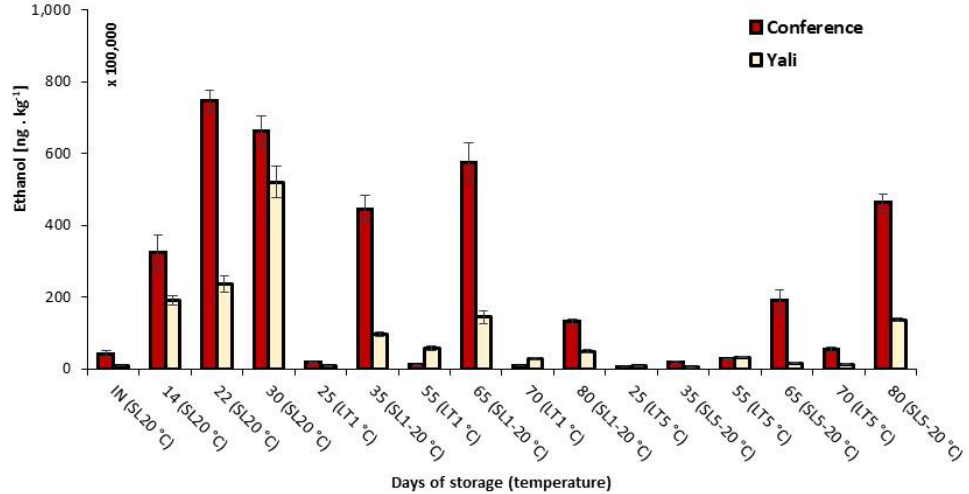
Figure 1. Concentration changes of ethanol in ‘Conference’ and ‘Yali’ pear cultivars depending on time and storage regimes. (SL20 °C — shelf-life at 20 °C; LT — low storage at 1 or 5 °C; SL1-20 °C, SL5-20 °C — shelf-life at 20 °C after storage at 1 or 5 °C).